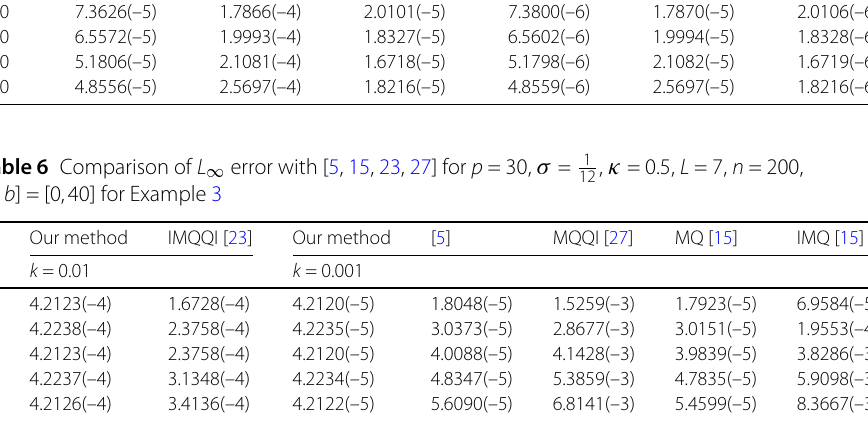
, t = 1, κ = 0.5, L = 7, [ a , b ] = [0,40] for Example 3 12